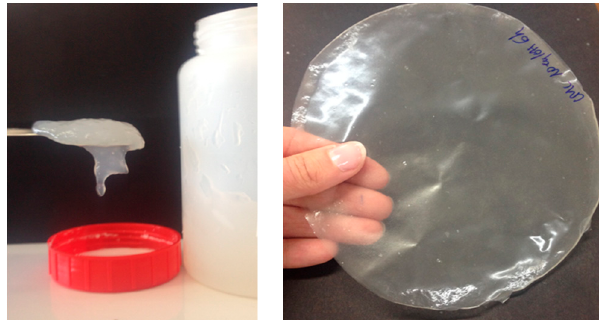
Figure 3. Images of the carboxymethylated nanofibrillated cellulose (CMC-NFC) suspension ( left ) and a sample of the casted film ( right ).